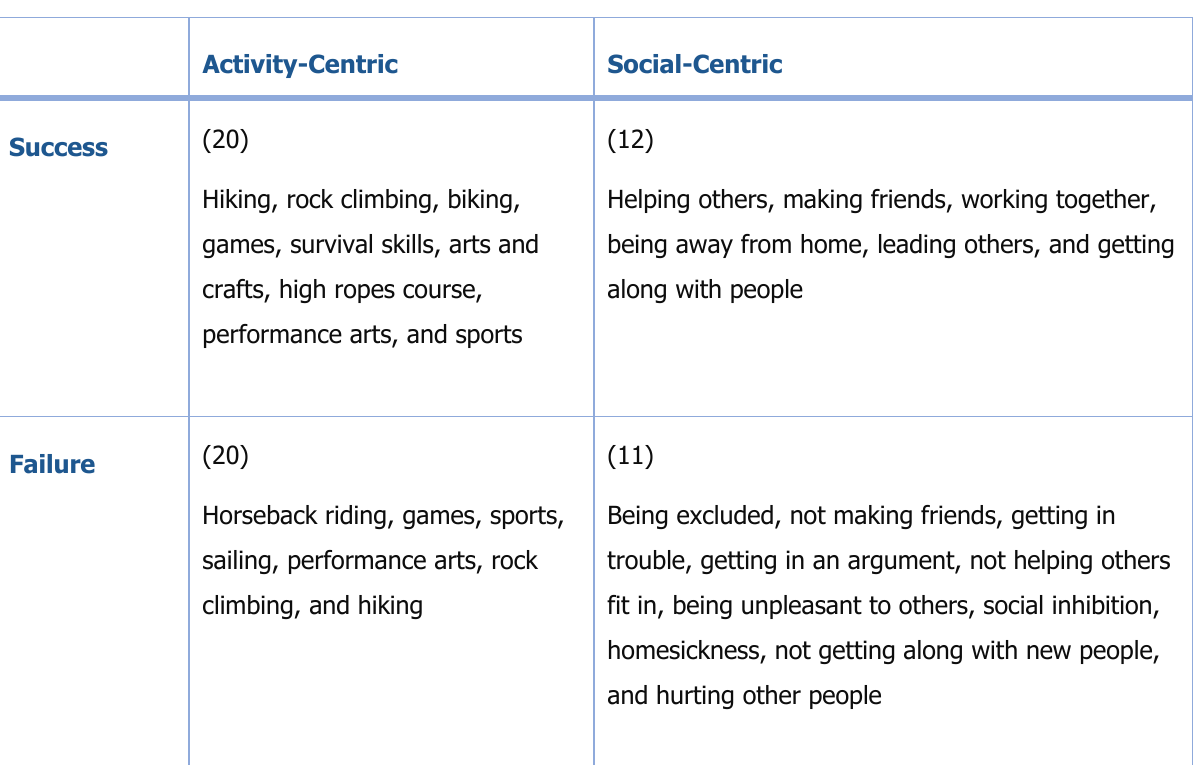
Table 1. Success and Failure Experiences at Summer